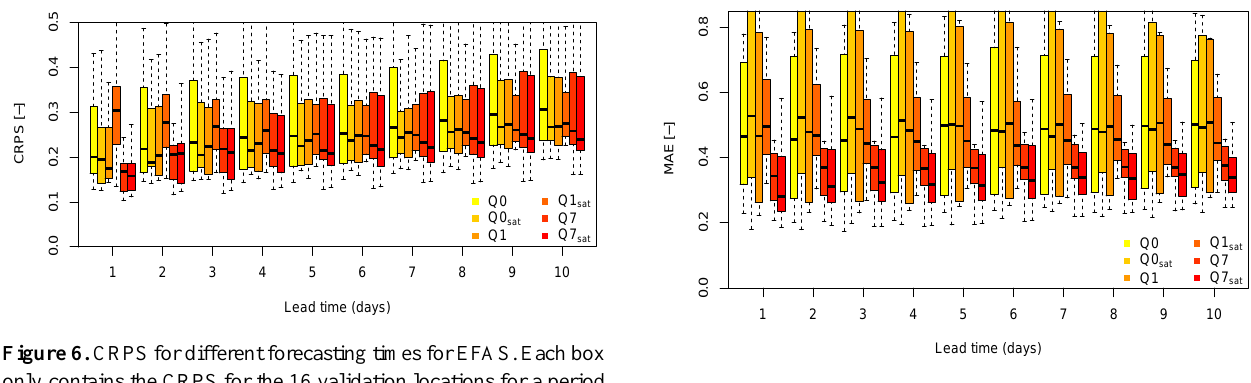
Figure 7. MAE for different forecasting times for EFAS. MAEs are standardized by dividing the MAE through the mean discharge. Each box only contains the MAE for the 16 validation locations for a period of 1year with two forecasts per